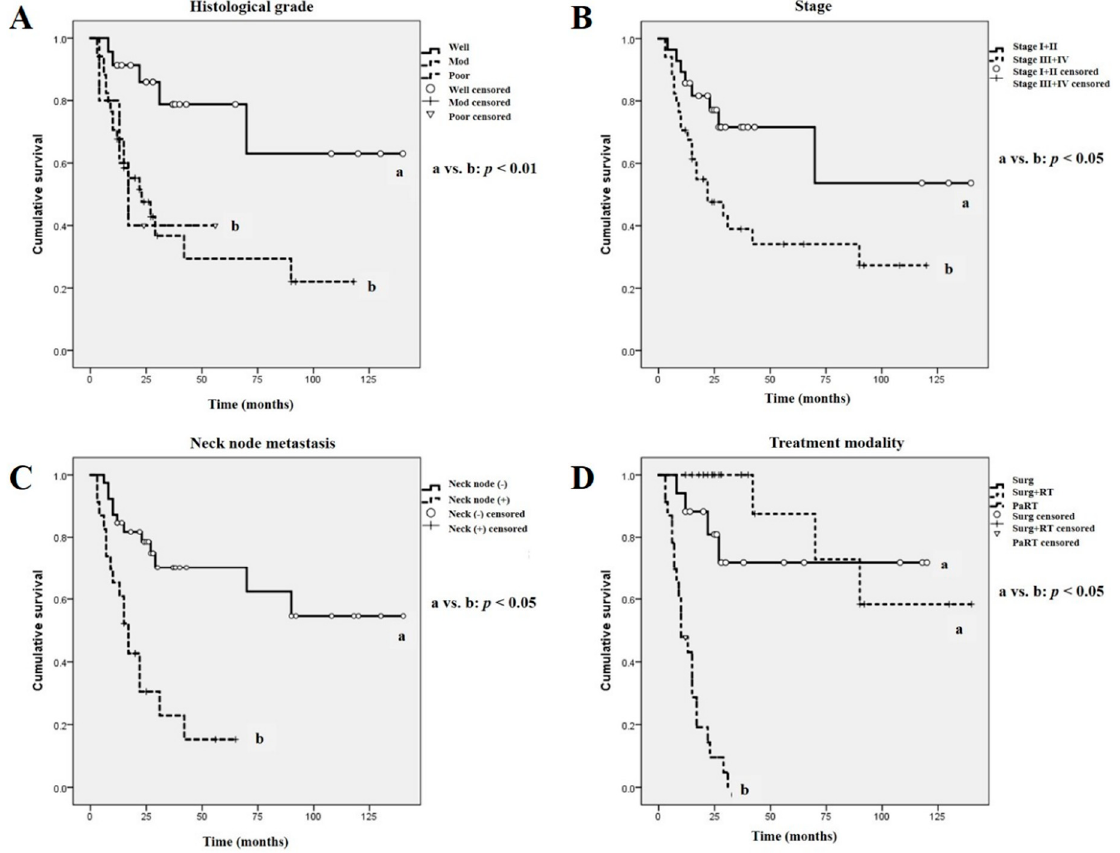
Figure 5. The overall survival rate of OSCCs according to clinicopathological features and treatment modality. ( A – D ) OSCC patients with well-differentiated tumors ( p < 0.01), early-stage tumors ( p < 0.05), negative neck node metastasis ( p < 0.05), and surgical treatment (Surg and Surg + RT) groups ( p < 0.05) showed significant higher overall survival rates than those in the corresponding opposite groups. Different letters denote statistically significant differences between groups ( p < 0.05 or p < 0.01).